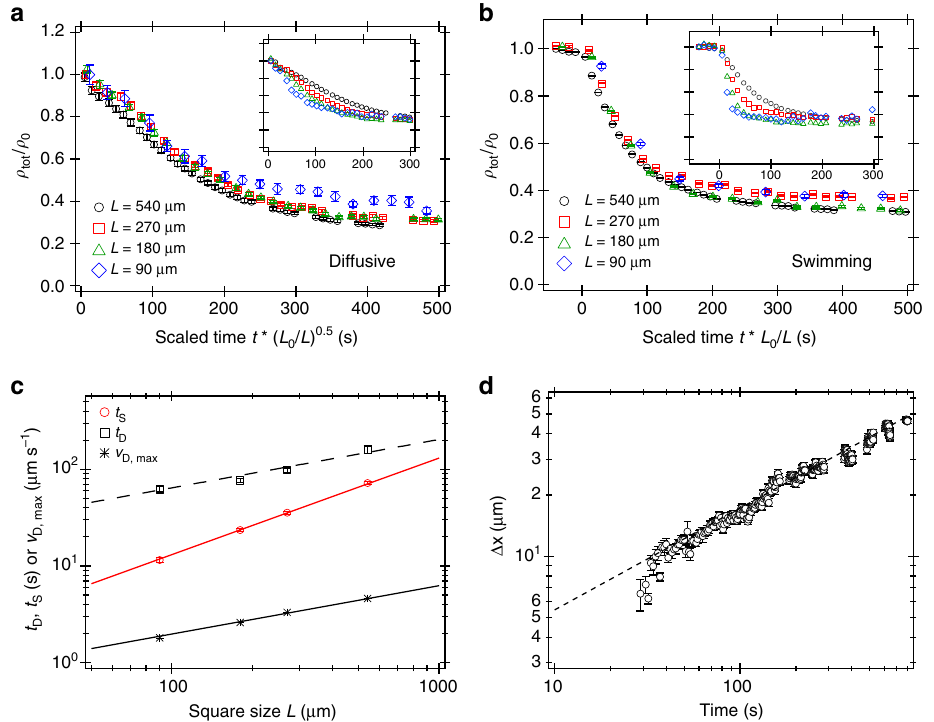
Fig. 3 Characterising the dynamics of pattern formation. Time evolution of normalised bacterial density (as measured by DDM, see Methods) inside squares of different dimensions L (inset, Fig. 2f), starting from a diffusive state and b uniformly swimming state. Inset: data plotted against time; main plots: ffiffiffiffiffiffiffiffiffi p L = L data collapse when scaling time by in a and L 0 / L in b (both with L 0 = 540 μ m). c Scaling of ‘ box emptying times ’ t D , t S , as well as v D ; max (the 0 maximum swimming speed reached when starting with diffusive cells) with square size L . d Shift of the peak position over time in the dark stripe (Fig. 2h); dashed line = power law fi t of slope 0.5. Error bars in a , b are SE of the q -averages and in c , d the SD estimates returned by the fi tting routines